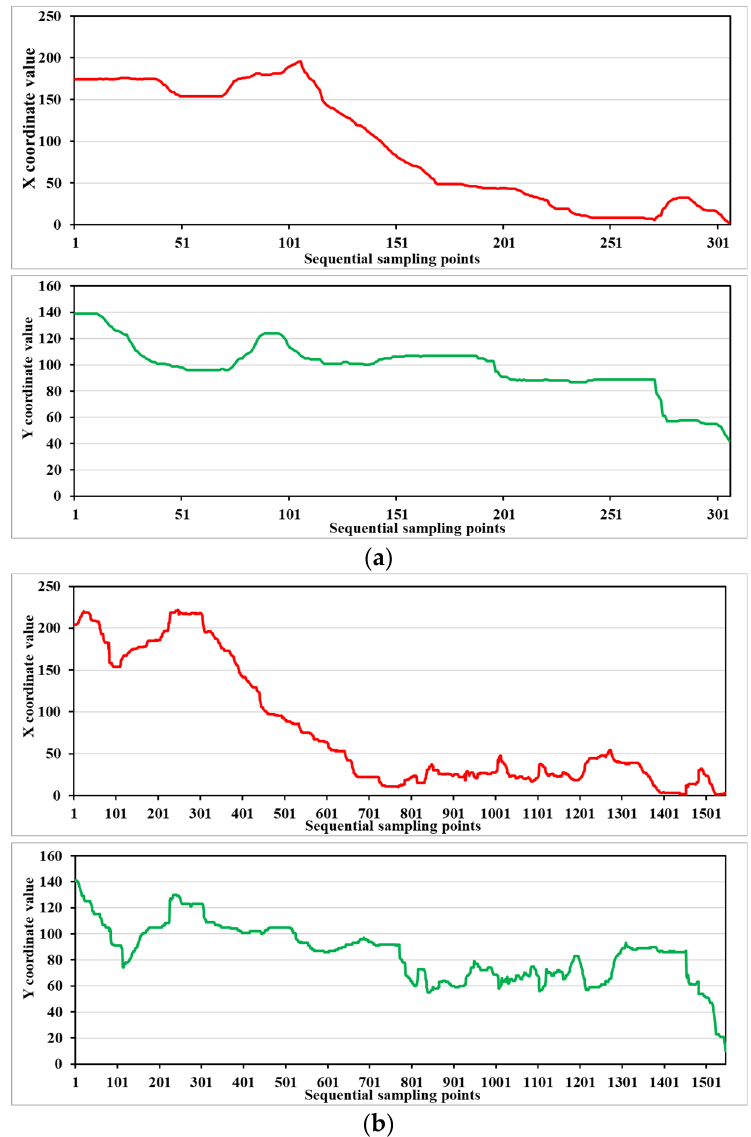
Figure 6. The slope variations of the guidewire tip in X and Y directions during one intravascular task performed by ( a ) an expert surgeon and ( b ) a novice surgeon, respectively.